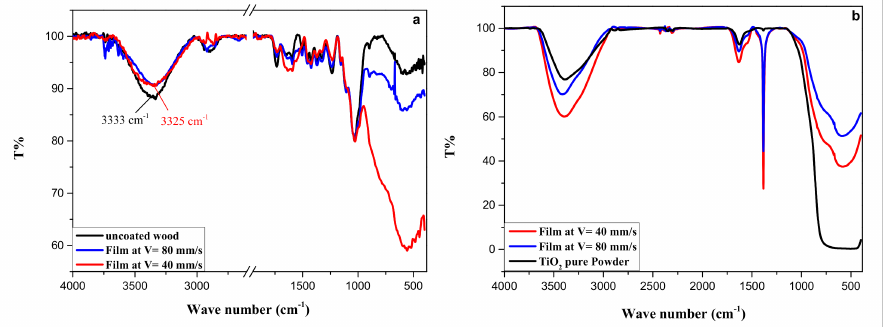
Figure 5. ( a ) Fourier transform infrared (FTIR) spectroscopy–attenuated total reflectance (FTIR–ATR) spectra for uncoated wood and TiO 2 -coated wood; ( b ) Spectra for TiO 2 pure powder and TiO 2 powder scraped from the coated glass